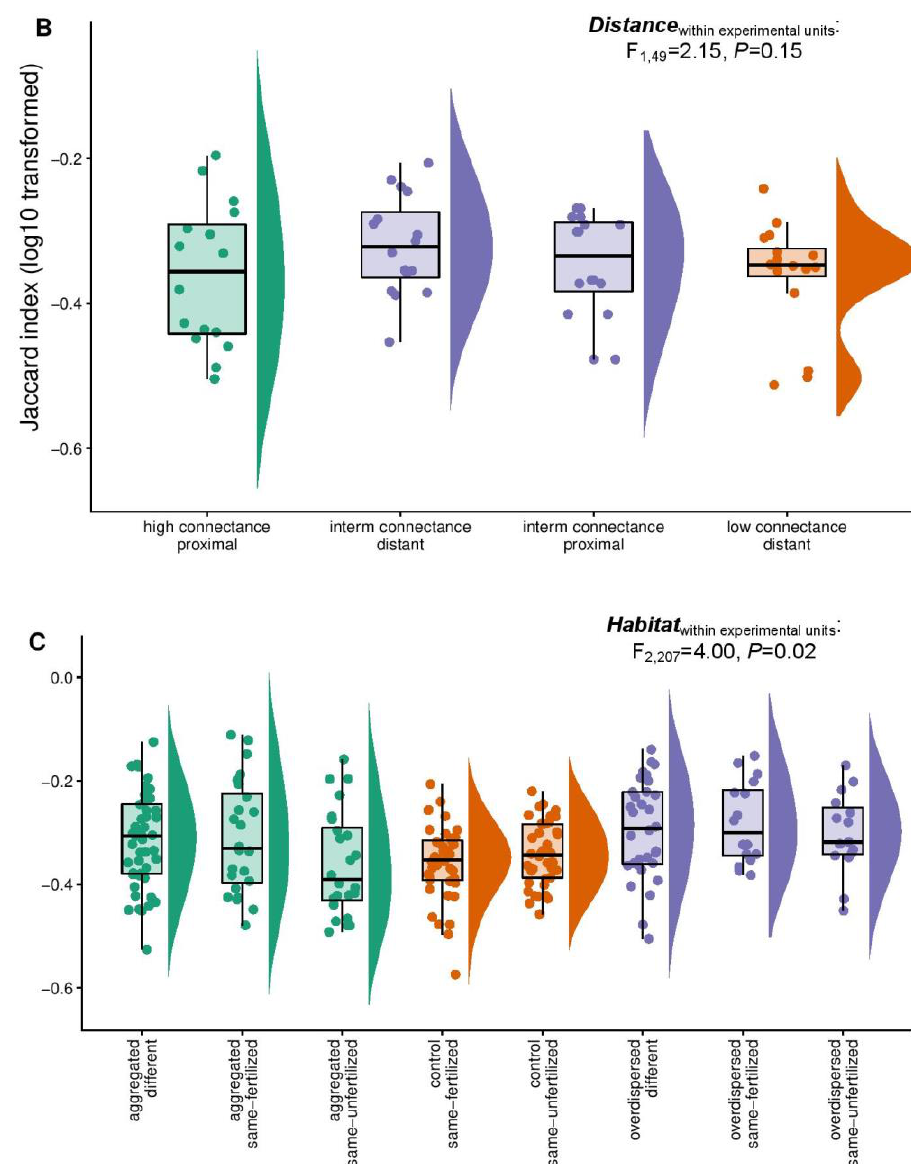
Figure 3. Jaccard index statistics from pairwise comparisons of samples within experimental units in ( A ) Experiment One; ( B ) Experiment Two; ( C ) Experiment Three. Note in panels ( A , B ) that in intermediate connected spatial arrangements we observe higher Jaccard distances between long- distance compared to short-distance “patches” (in the case of Experiment Two a trend) within-subjects distance effect; F 1,49 = 6.34, p = 0.015 in Experiment One; F 1,49 = 2.12, p = 0.15 in Experiment Two) and in panel ( C ) that Jaccard distances differed (F 2, 207 = 4, p = 0.02) within experimental units in the overdispersed and aggregated